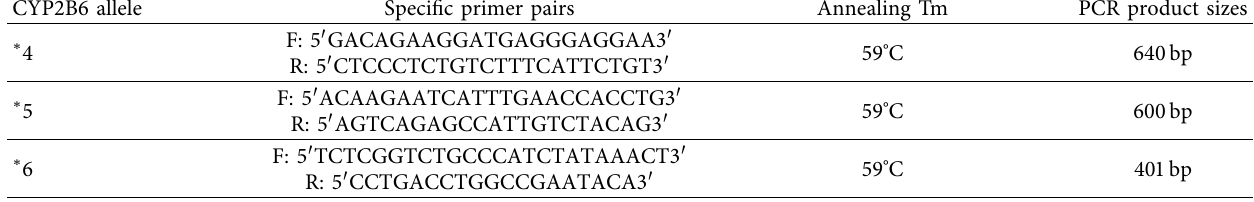
Table 1: Specific primers for amplification and evaluation of each CYP2B6 defective allele. CYP2B6